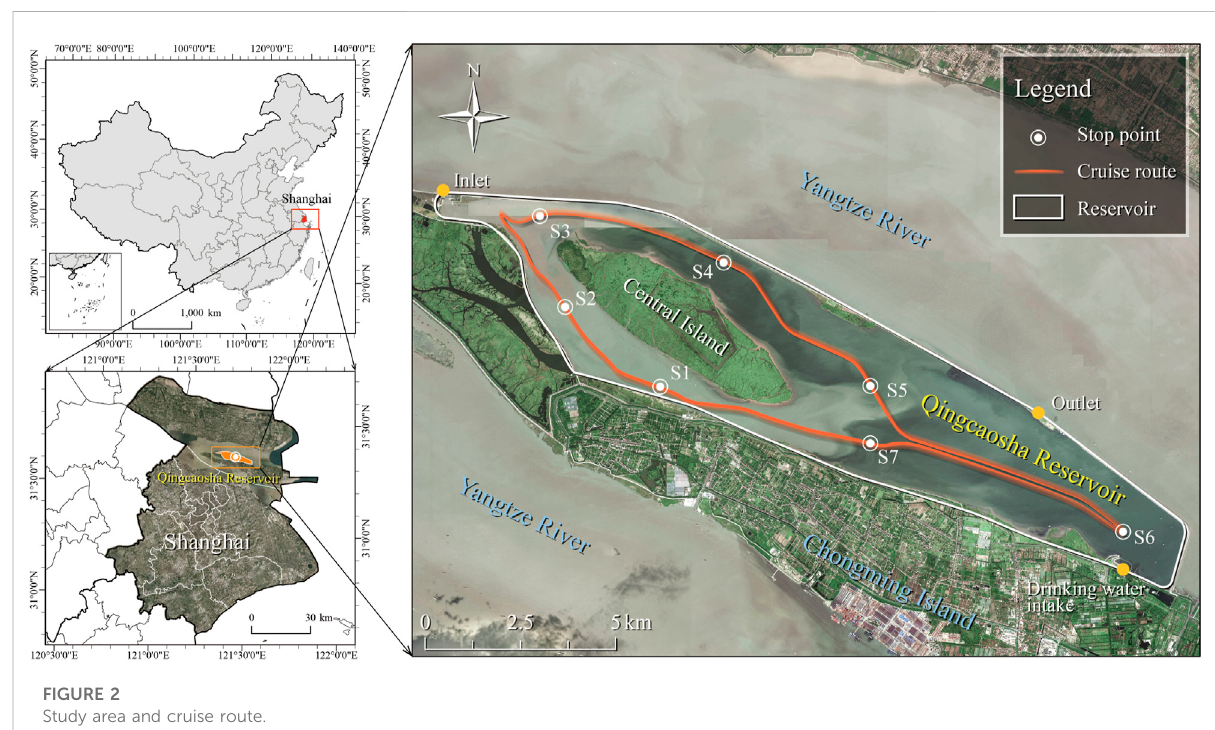
FIGURE 2 Study area and cruise